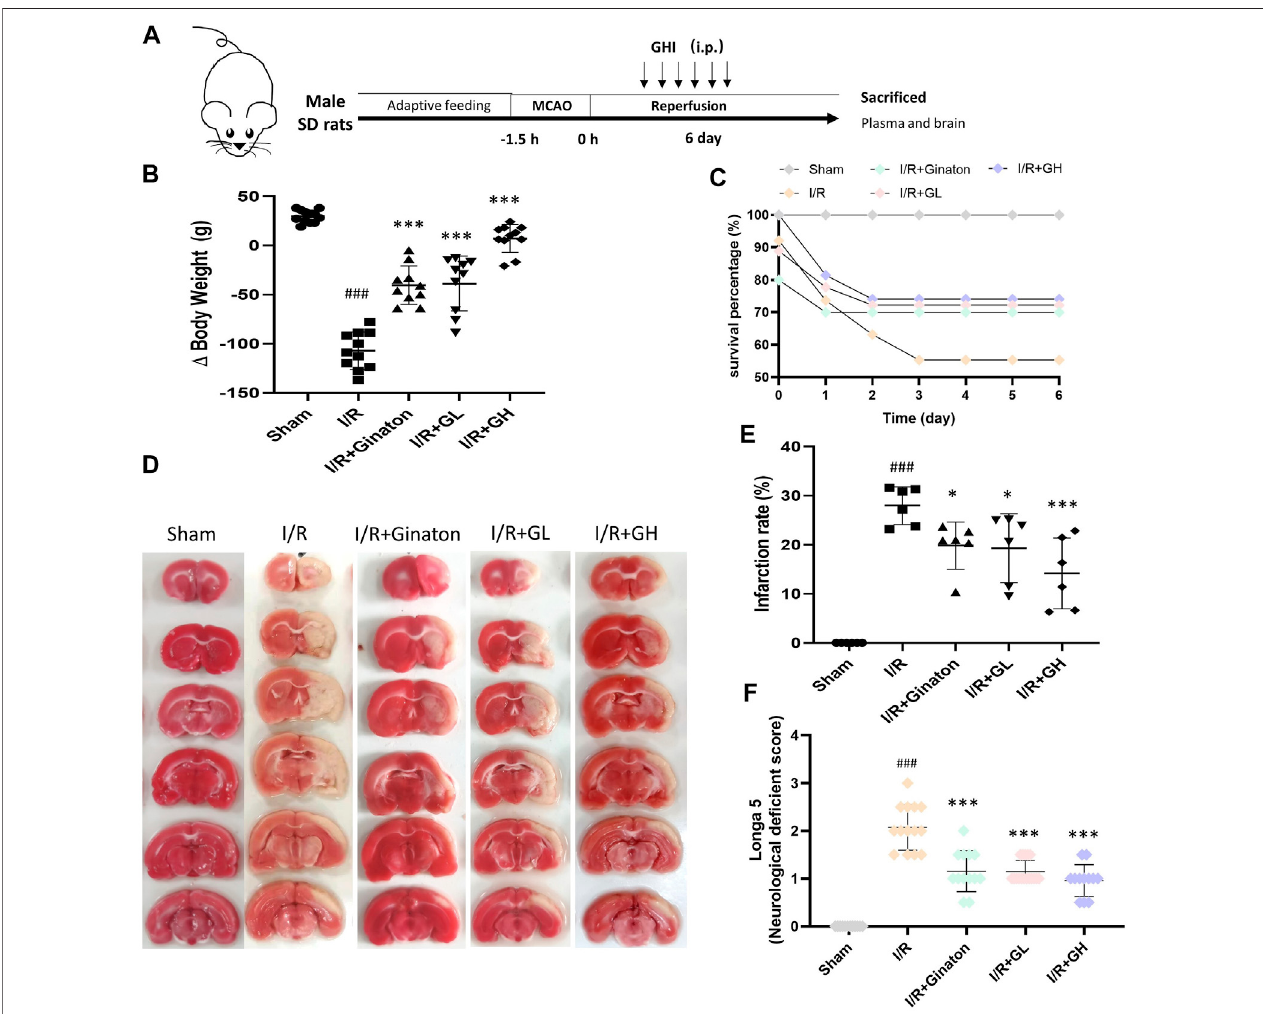
FIGURE 1 | GHI protected against MCAO-induced I/R injury at day 6. (A) Schematic diagram of MCAO-induced rat model treated with GHI; (B) Δ body weight ( n =10 – 12); (C) Survivalpercentage( n =16 – 32); (D) TTCstainingrepresentativeimages; (E) thequali fi edinfarctionratiothroughTTCstainingbyusingImageJ( n =6); (F) Longa 5 neurological de fi cient scores ( n = 12); ### p < 0.001 compared with sham, * p < 0.05, *** p < 0.001 compared with the I/R